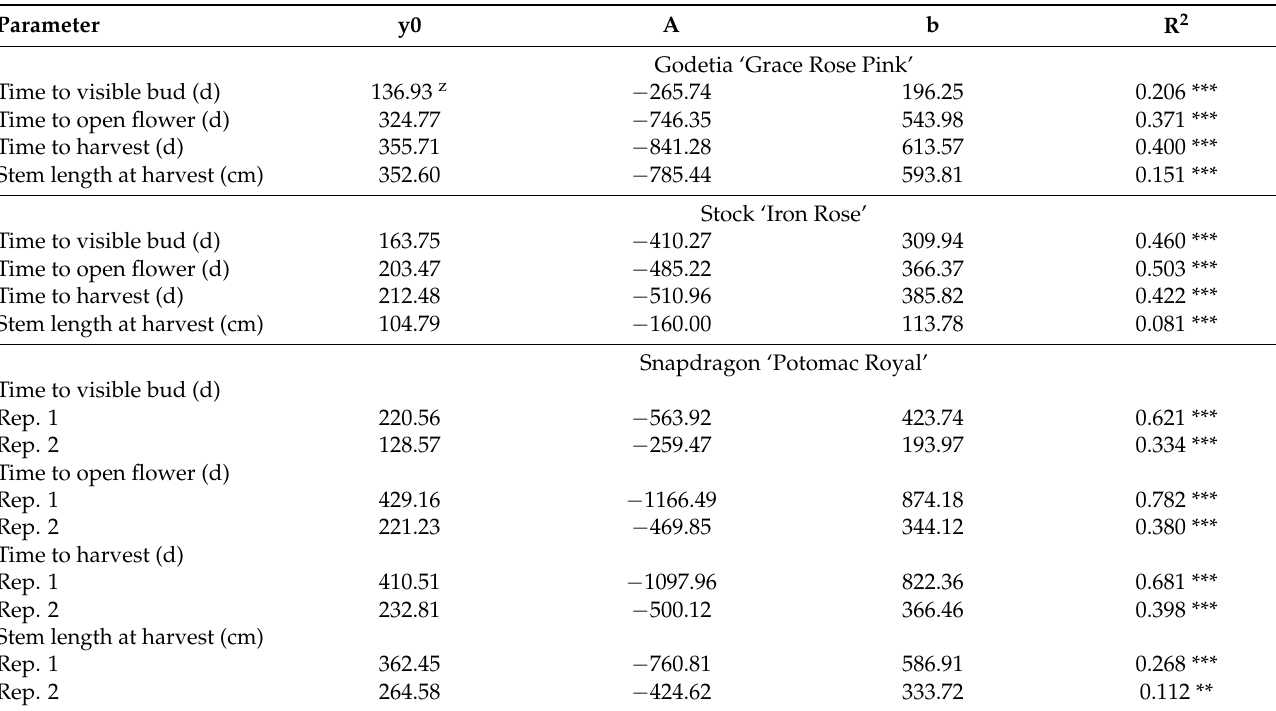
Table 5. Regression equations and R 2 for time to visible bud, time to open flower, time to harvest, and stem length at harvest of godetia ‘Grace Rose Pink’, stock ‘Iron Rose’, and snapdragon ‘Potomac Royal’ in response to the estimated phytochrome photoequilibrium of each supplemental lighting treatment. ** and *** indicate model significance at p < 0.001 and p < 0.0001, respectively. All models are in the form of: ƒ = y0 + a ∗ PPE + b ∗ PPE 2